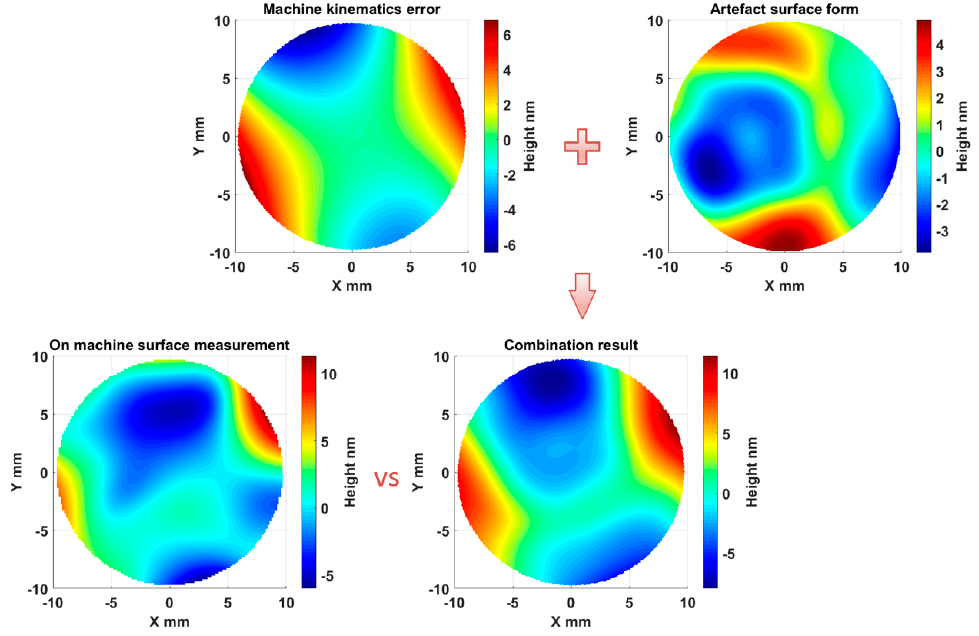
Figure 17. DRI on-machine measurement vs. the combination of the kinematics error and Fisba measurement.